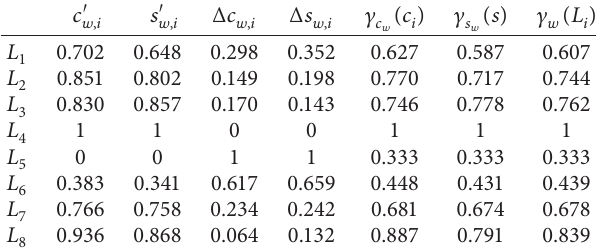
Table 5: The calculation of grey relational grade based on the weighted choice value sequence and the weighted score value se- quence in Example 3.